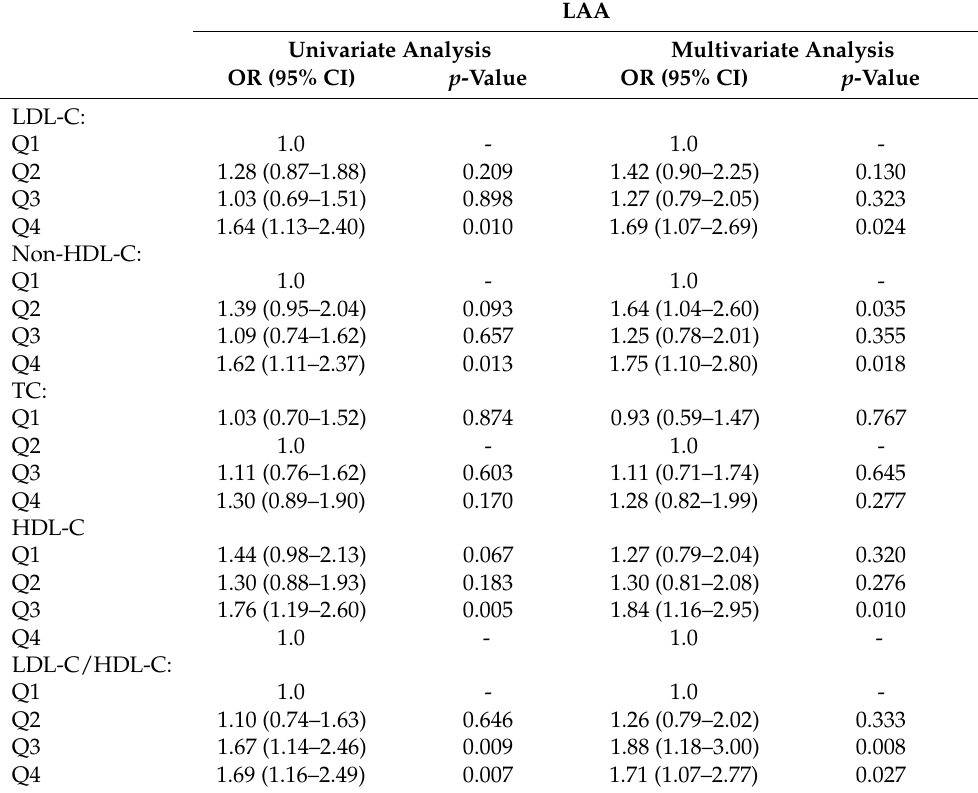
Table 2. Lipid Parameters and Associations with LAA.